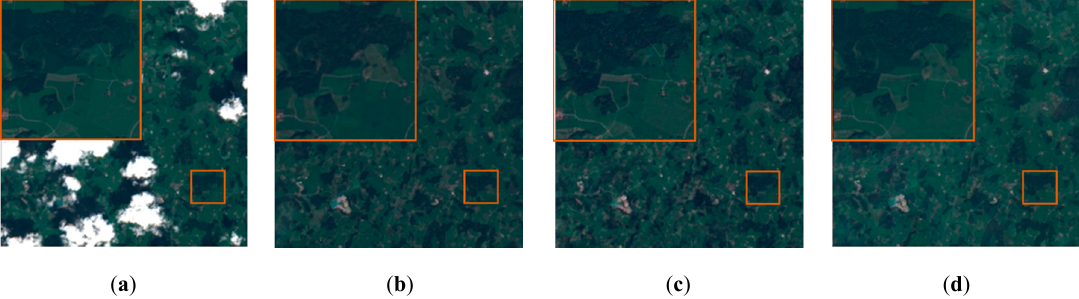
Figure 7. Results of Area 1 in the real experiment. ( a ) Ground truth of the optical image. ( b ) Pix2pix. ( c ) SAR-opt-GAN. ( d ) The proposed method.